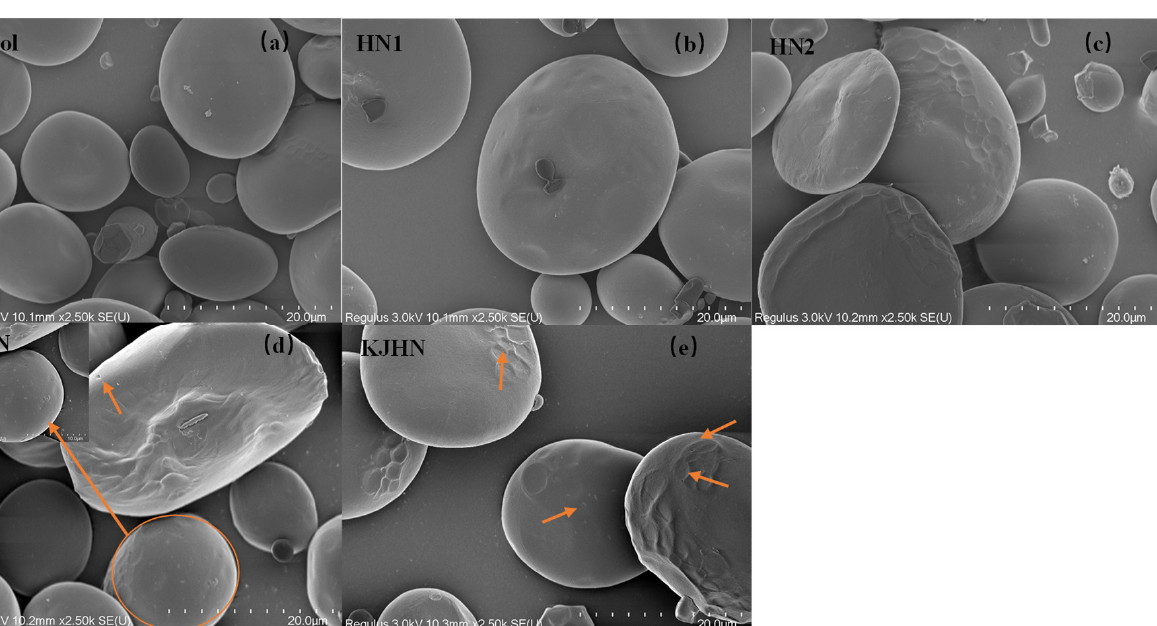
Table 2. Thermal properties, crystallinity and short-range order degree of starch from dried noodles. Sample